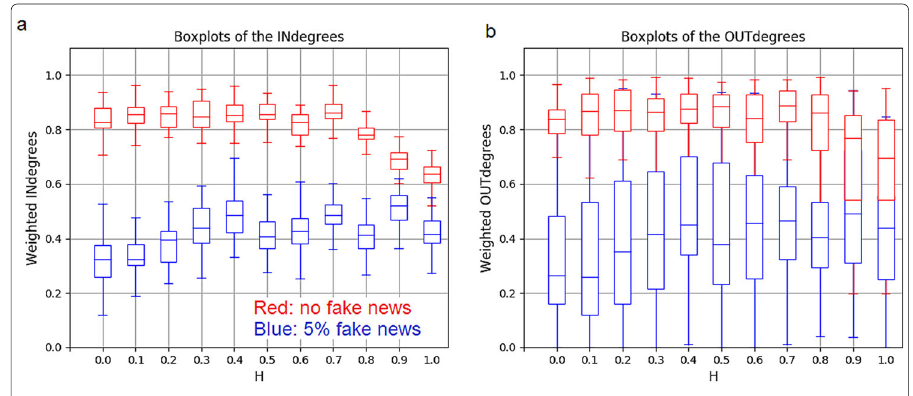
Fig. 4 Box-plots of the a in-degrees and b out-degrees of the nodes of the optimized communication networks as a function of H , for 5% and 0% fake news ratios. In both subfigures blue represents 5% fake news ratio, and red denotes the case when there are no fake news. The weighted in-degree values of the agents are much more homogeneous than their weighted out-degree values independently of H or R FN . As a general rule, exposure to fake news calls forth smaller in-degree and out-degree values, in agreement with the decreased communication activity. Exposure to fake news also disperses the out-degree values, marking the diversification of agents regarding their information-spreading